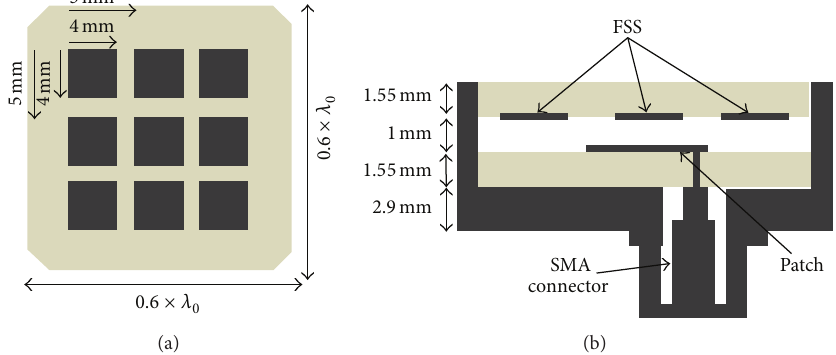
Figure 2: (a) FSS dimensions. (b) Detailed dimensions heights of the pixel (inside view, cut-plane at the middle along ( 0𝑦